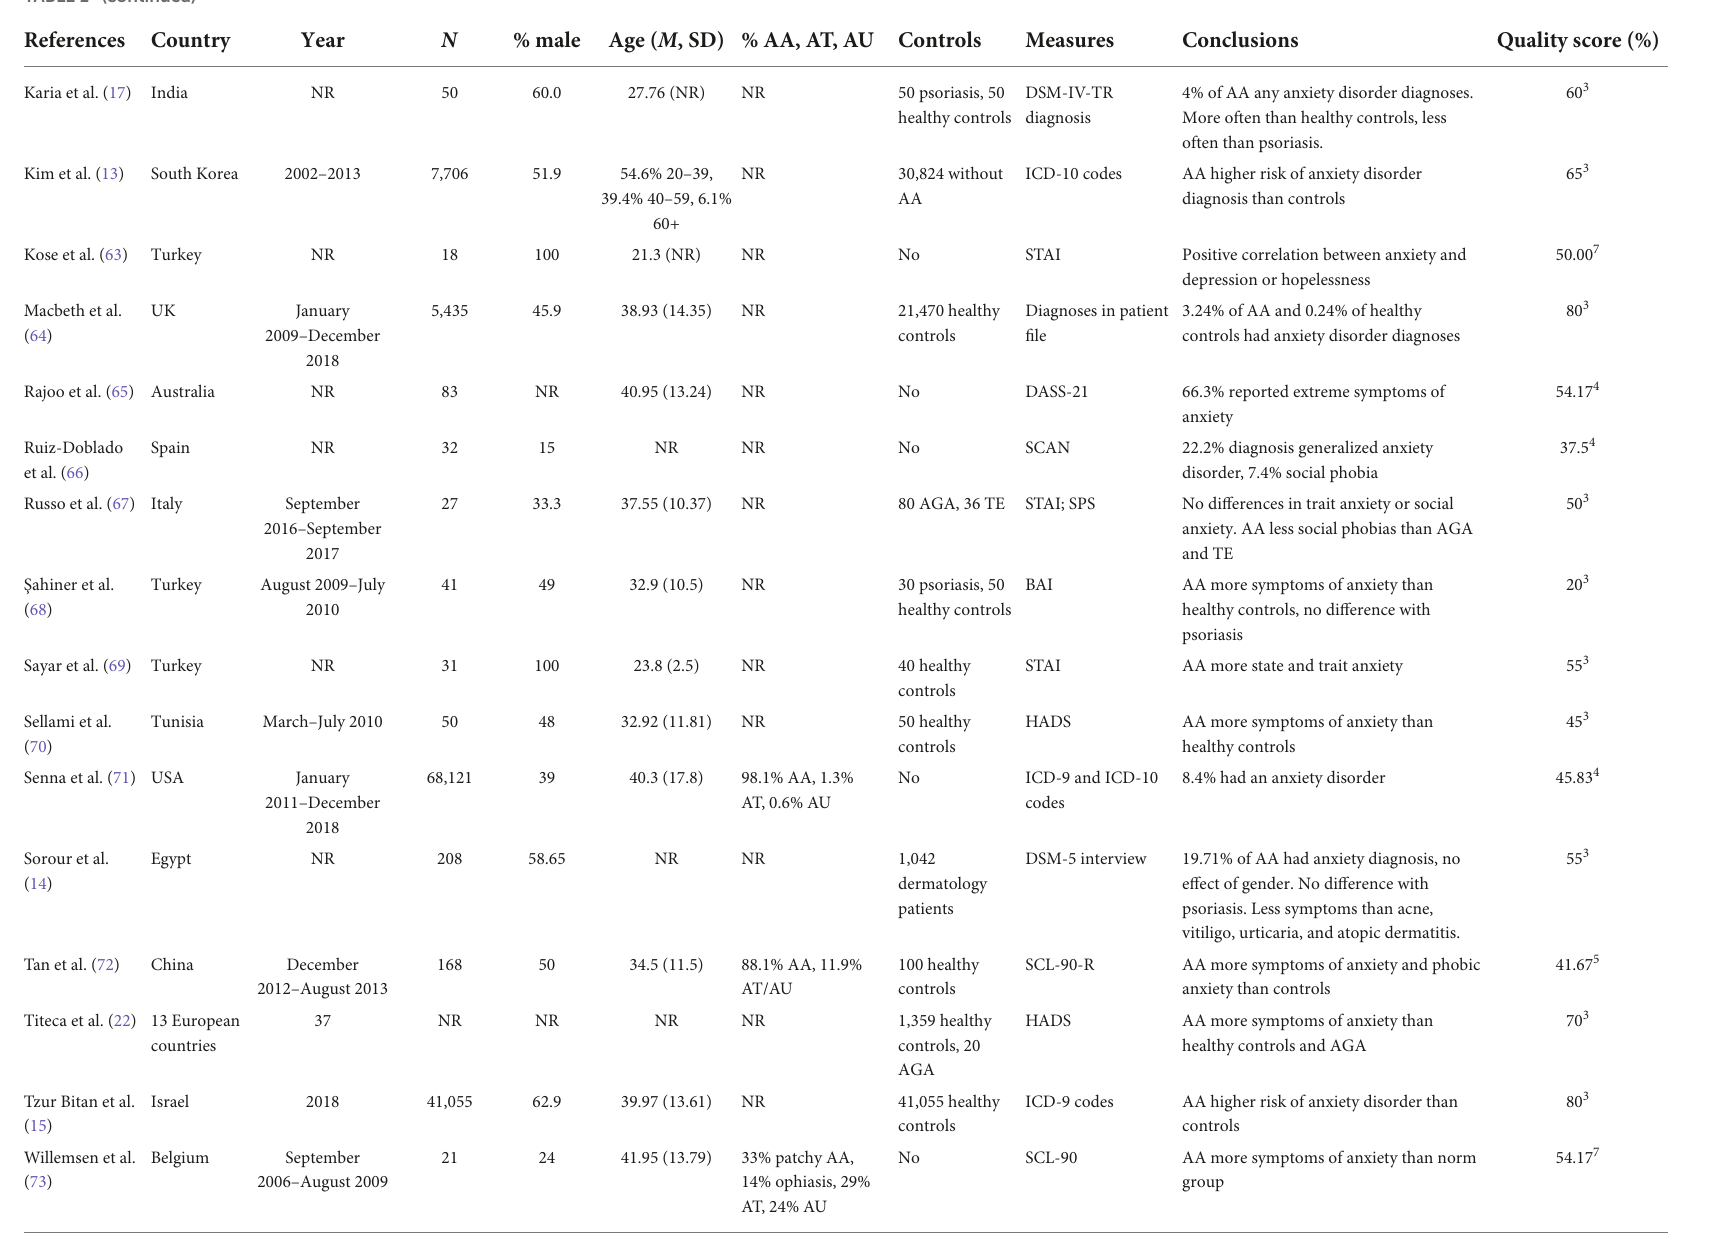
19.71% of AA had anxiety diagnosis, no effect of gender. No difference with psoriasis. Less symptoms than acne, vitiligo, urticaria, and atopic